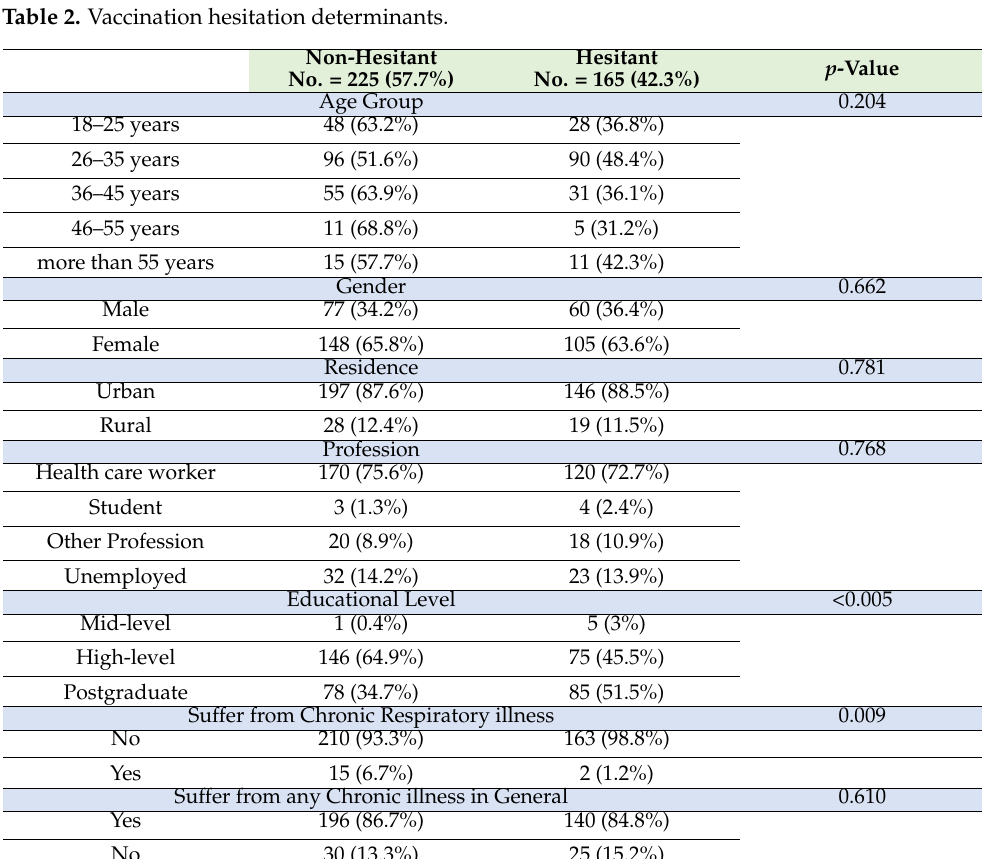
Table 2. Vaccination hesitation